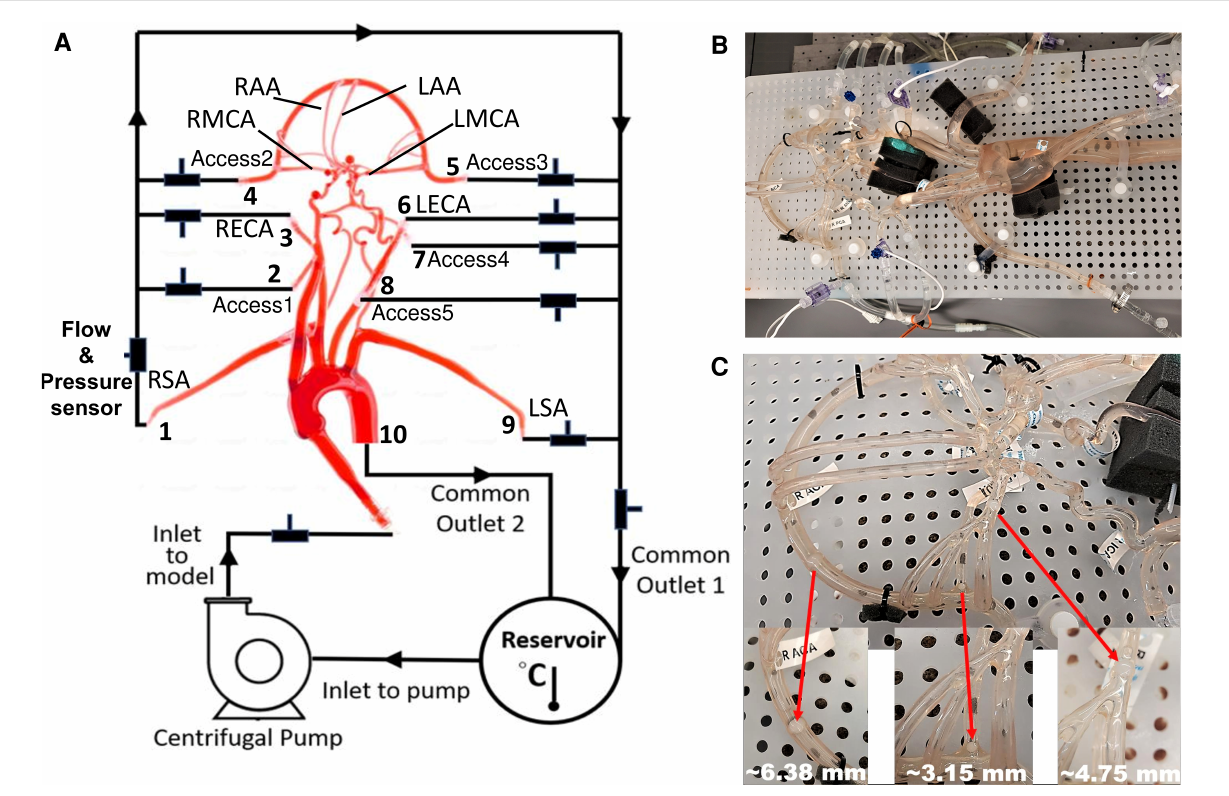
FIGURE 1 schematic and photographs of the in vitro circulatory fl ow loop illustrating the ( A ) experimental setup, ( B ) the fl ow loop setup with the instrumentation that was used to measure fl ow rate and pressure at various cerebrovascular outlets, and ( C ) location of nylon spherical clots used to mimic a stroke condition. Here, LSA and RSA are the left and right subclavian arteries, LECA and RECA are the left and right external carotid arteries, LMCA and RMCA are the left and right middle cerebral arteries, and LAA and RAA are the left and right anterior arteries,